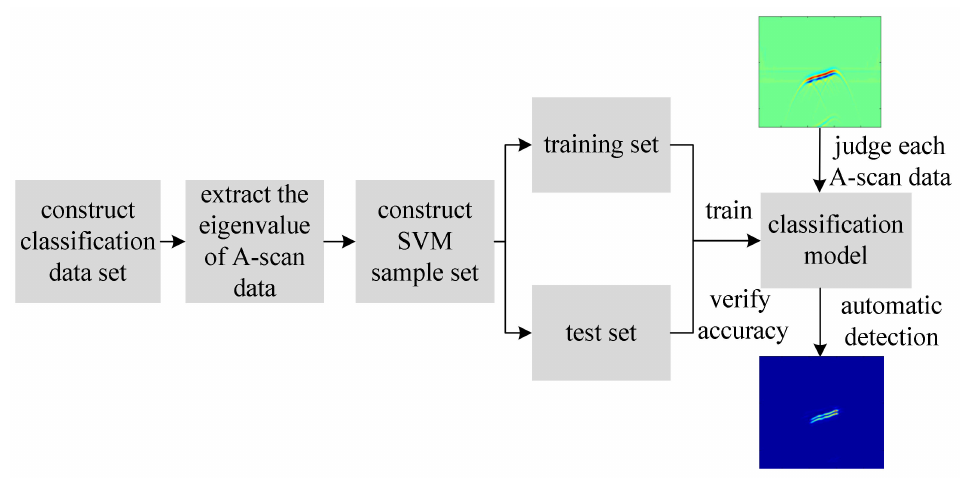
Figure 7. The processing chain of automatic disease